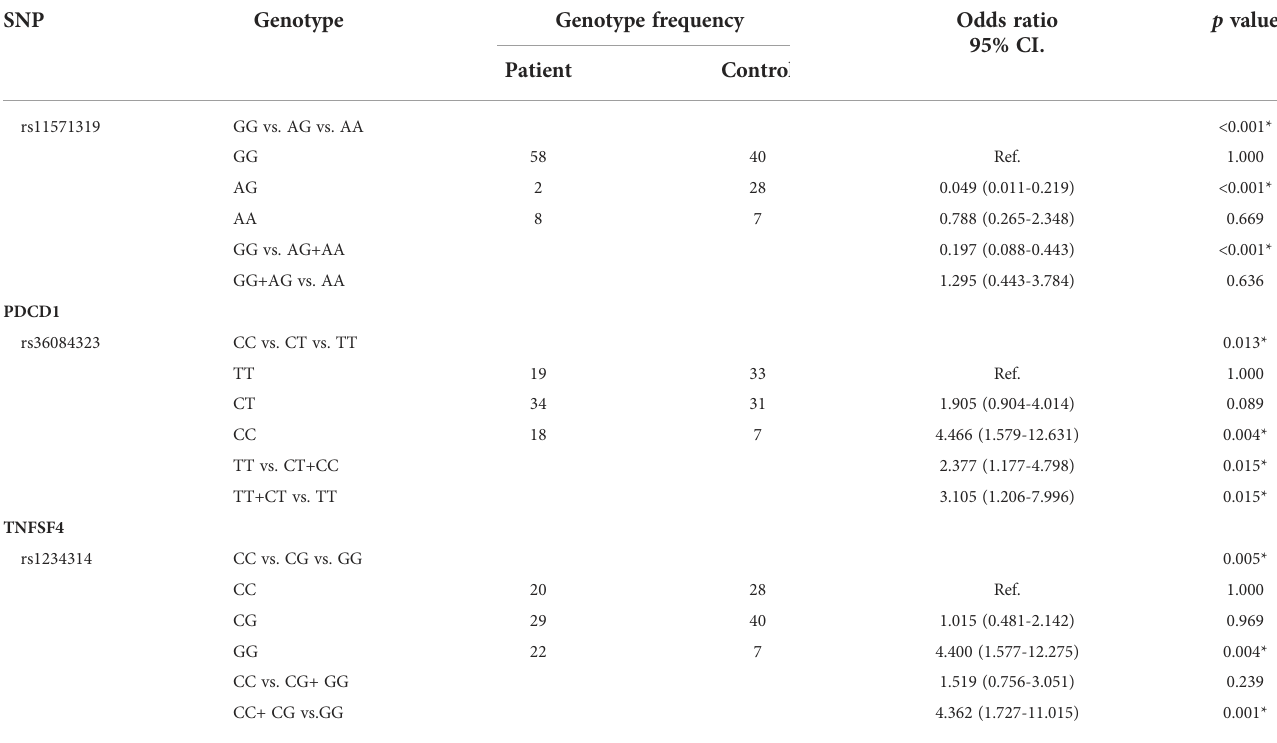
TABLE 4 Genotype frequencies of the signi fi cant SNPs in SLE cases and healthy controls. Haplotypes Freq. Cases Freq. Controls OR 95% CI. p value